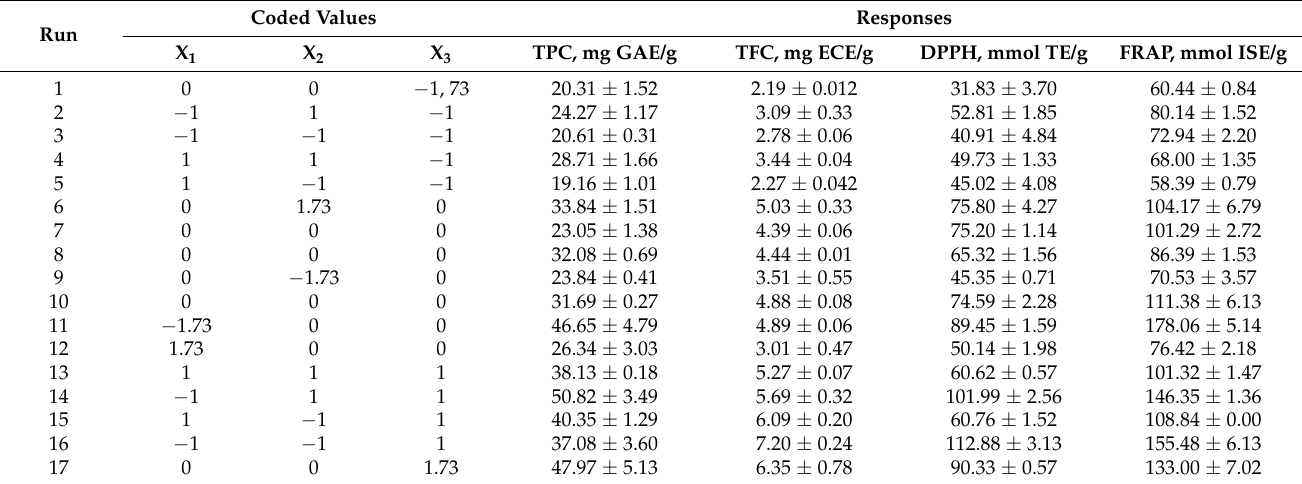
Table 2. Actual units, coded units and responses of central composite